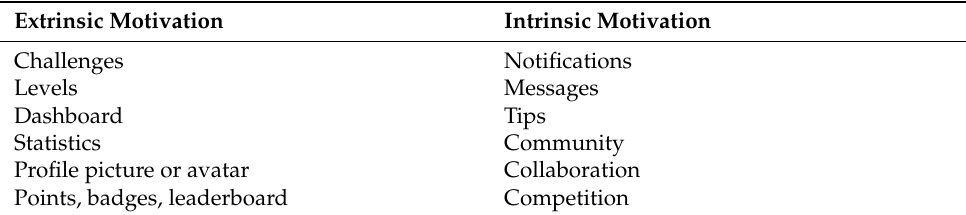
Table 2. Extrinsic and intrinsic motivations used in